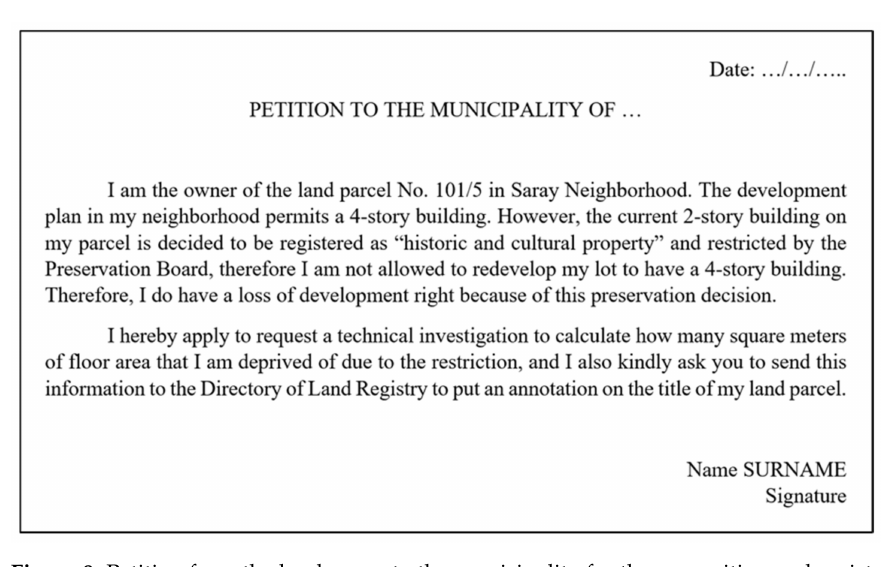
Figure 8. Petition from the landowner to the municipality for the recognition and registration of the unusable development right on land registry.